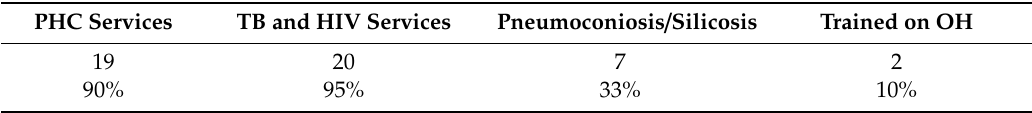
Table 6. Available primary and occupational health services in